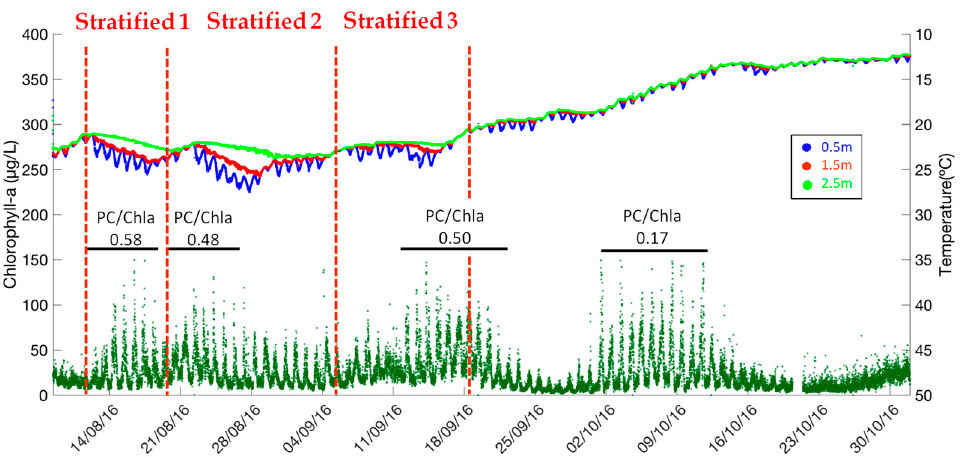
Figure 5. Water temperature (upper—reversed y axis) and chlorophyll-a (lower) with average phycocyanin to chlorophyll-a ratio (black horizontal bar) at 1.5 m depth of the point B from 8 August 2016 to 31 October 2016.